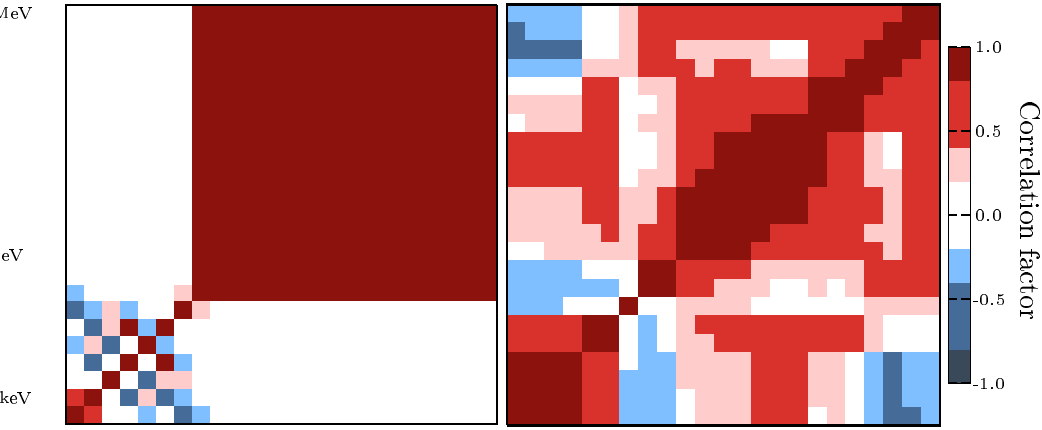
Figure 3: Same as Fig. 2, but for 160